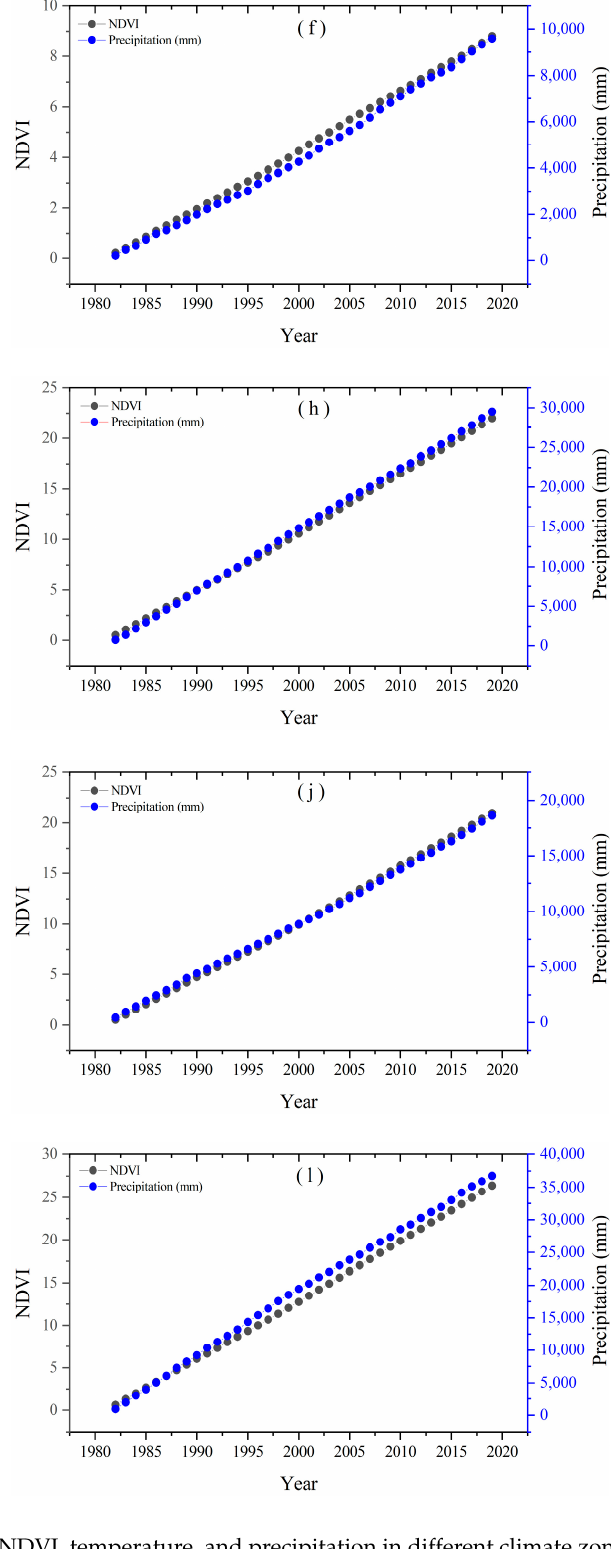
Figure 6. The cumulative curve of NDVI, temperature, and precipitation in different climate zones from 1982 to 2019 (( a , b ) H1B1; ( c,d ) H1C1; ( e,f ) H1C2; ( g,h ) H2AB1; ( i,j ) H2C1; and ( k,l ) H3).